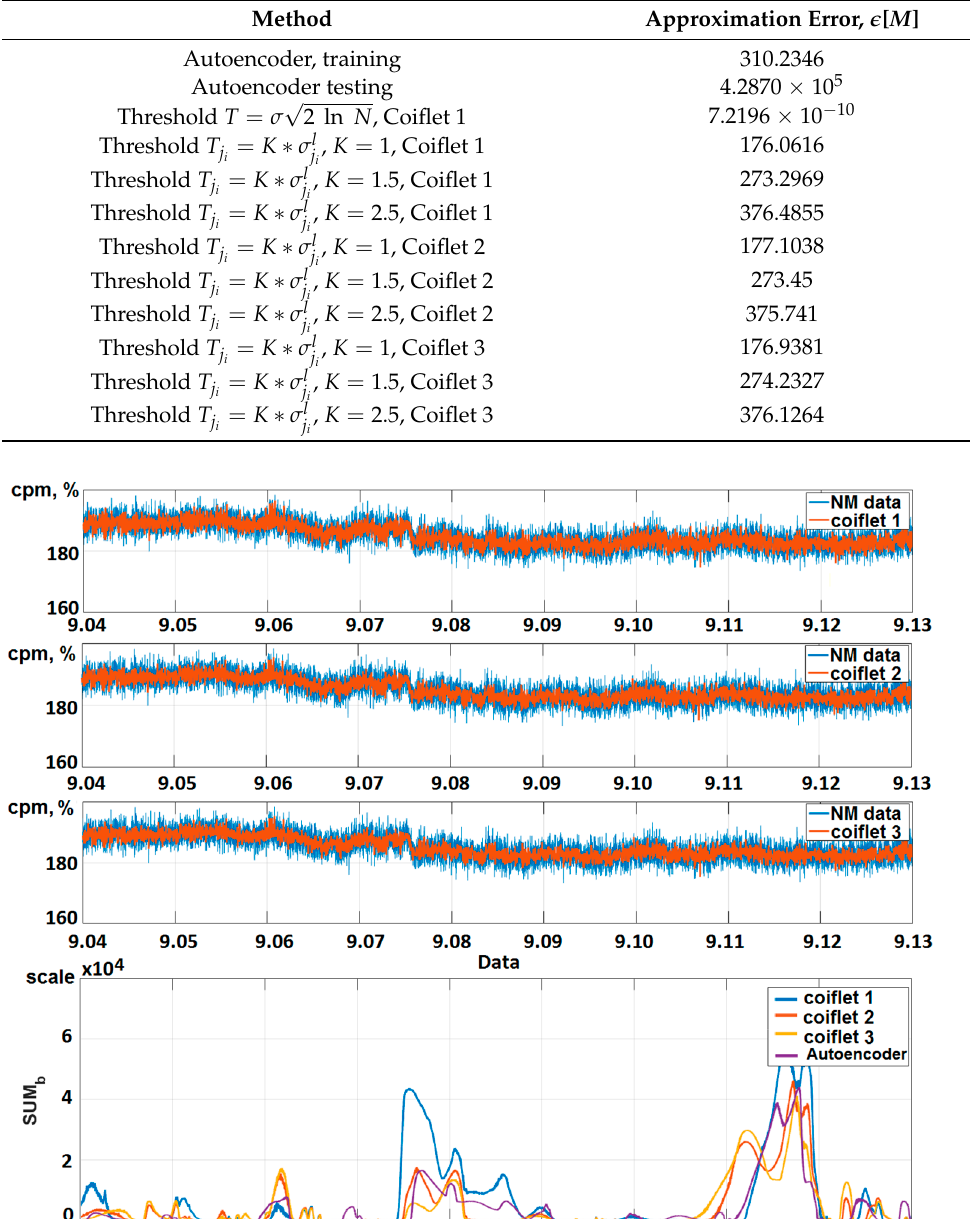
Figure 8. NM data processing results, the threshold used was T j